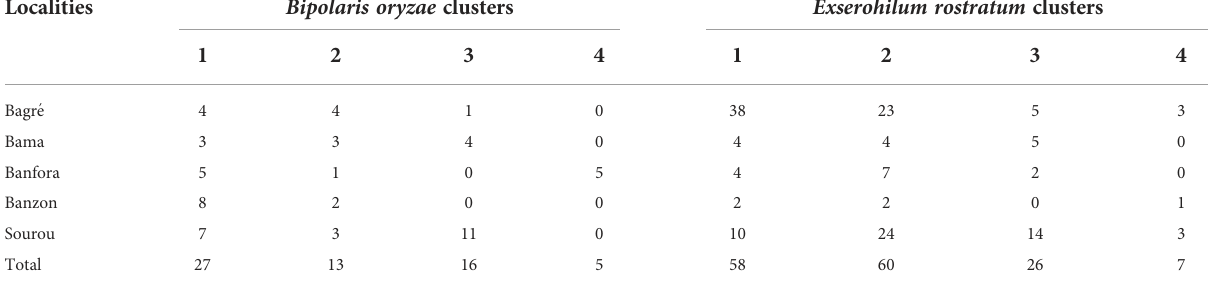
TABLE 1 Distribution of Bipolaris oryzae and Exserohilum rostratum clusters obtained by DAPC analysis in fi ve rice-growing areas of Burkina Faso. Localities